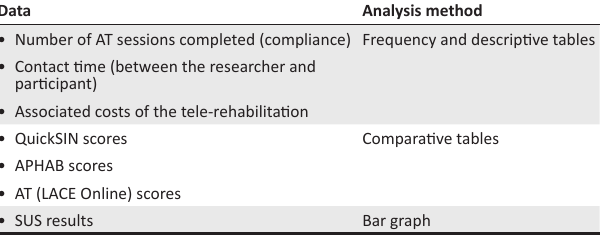
TABLE 1: Summary of quantitative data